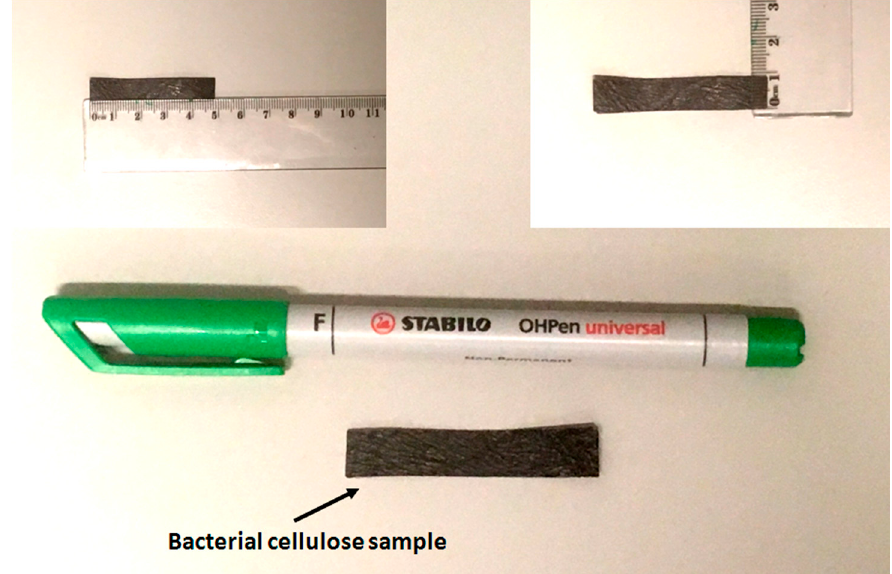
Table 1. Characteristics of the BC transducer used as a green energy harvester.